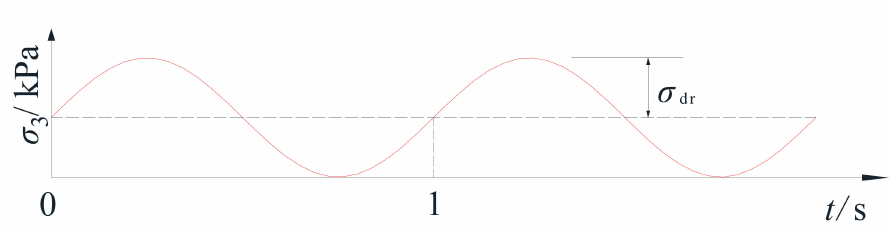
Figure 6. Schematic diagram of horizontal cyclic loading.